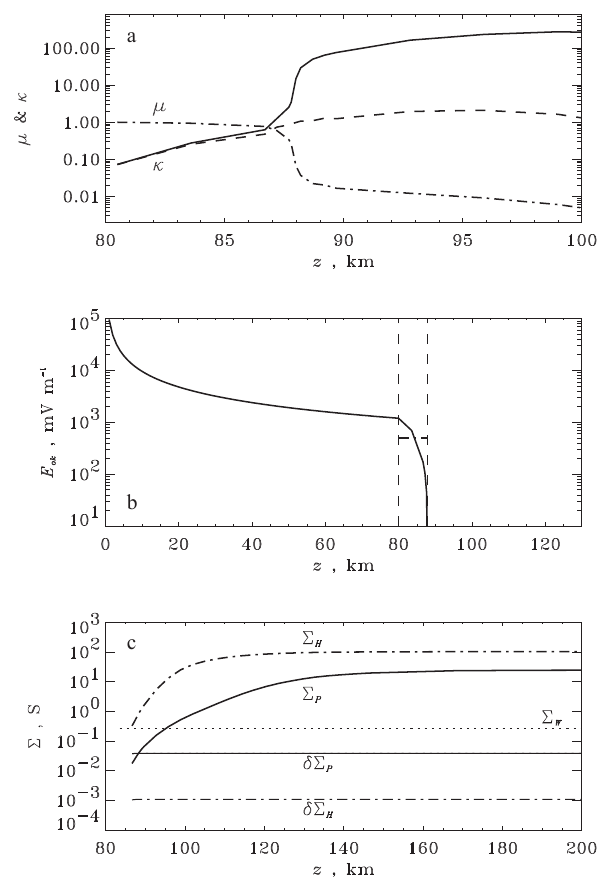
Fig. 4. (a) Variation with height of the real refractive index µ (dashed-dotted line) and the absorption coefficient κ : the exact so- lution (6) is shown by a solid line and the approximated solution (5) by a dashed line. (b) Decay of the amplitude E ok of the transmitted HF wave with height. The absorption layer is limited by the ver- tical dashed lines. A characteristic plasma field E p in the absorp- tion layer is shown by a horizontal dashed-dotted line. (c) Height integrated Hall, Pedersen, magnetospheric conductivities and their perturbations under the conditions discussed in Sects. 2.3, 3.1,